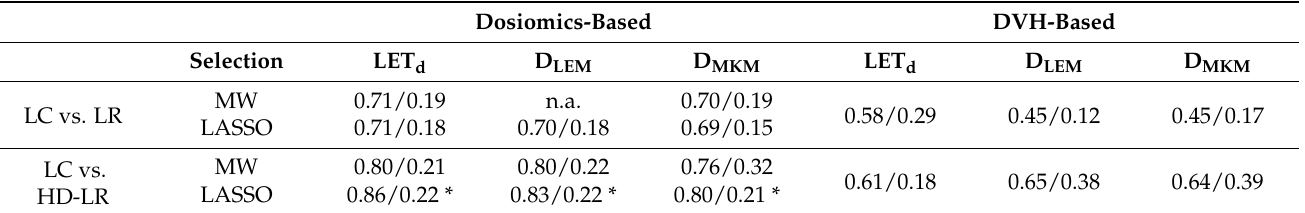
Table 1. C-indices corresponding to the r-Cox models with different settings. Results are shown in terms of median/IQR. Best values for each map are highlighted with the symbol *. Dosiomics-Based